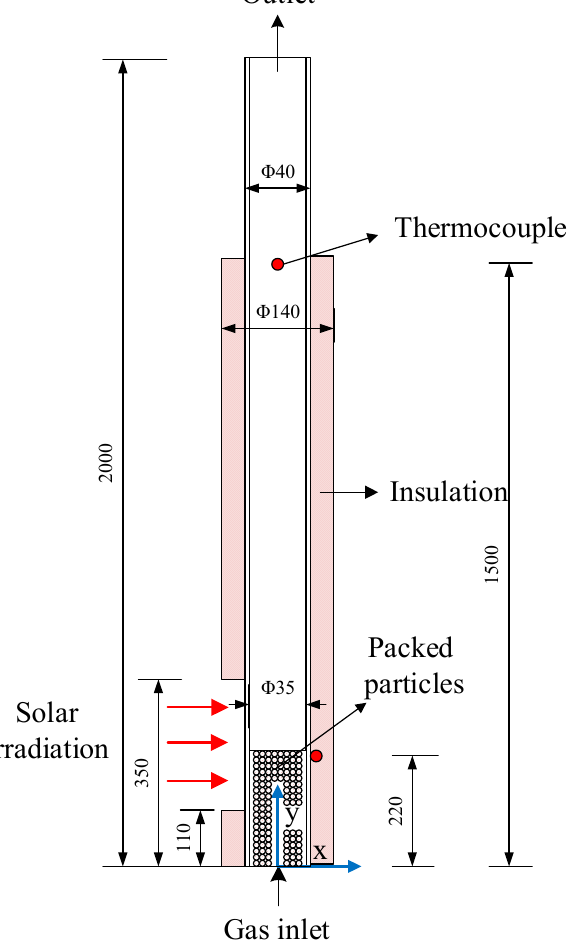
Figure 4. The structure and corresponding coordinate system.